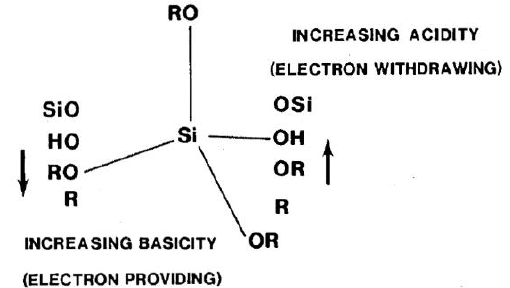
Figure 7. The inductive effect of different substituents on the hydrolysis in basic and acidic media. Repainted with permission from [4]. Copyright Elsevier, 1990.